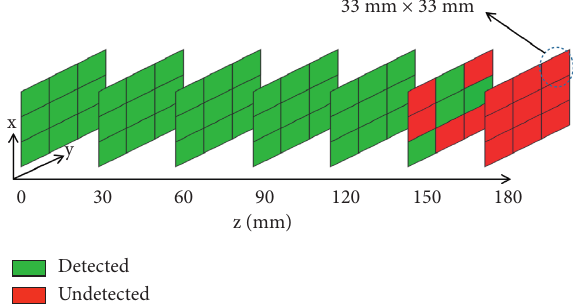
Figure 11: Four-branch antenna measurement results.